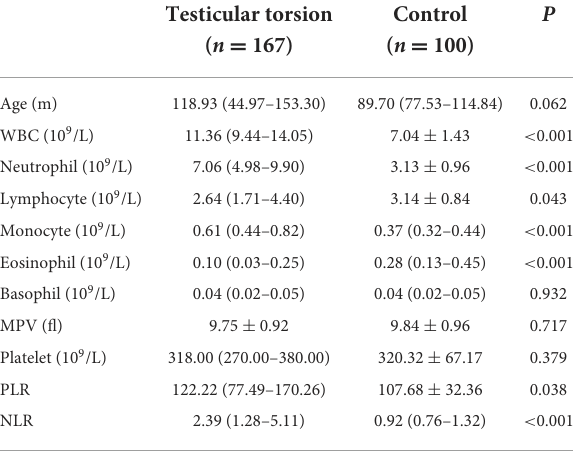
TABLE 1 Baseline characteristics of patients with testicular torsion and healthy children.